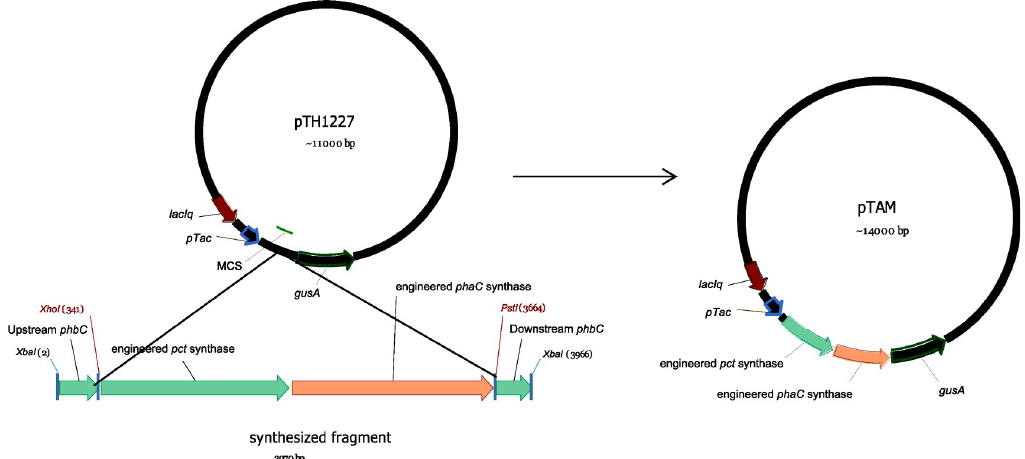
be accessed via accession Nos. KT382270–KT382273.